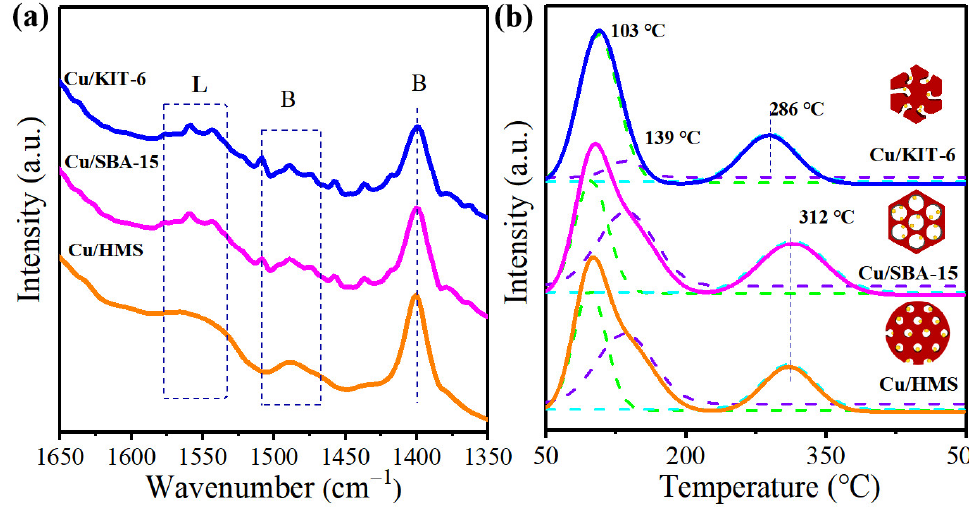
Figure 6. ( a ) In situ NH 3 -FTIR spectra of Cu/KIT-6, Cu/SBA-15, and Cu/HMS catalysts at 25 °C; ( b ) NH 3 -TPD analysis of Cu/KIT-6, Cu/SBA-15, and Cu/HMS catalysts.